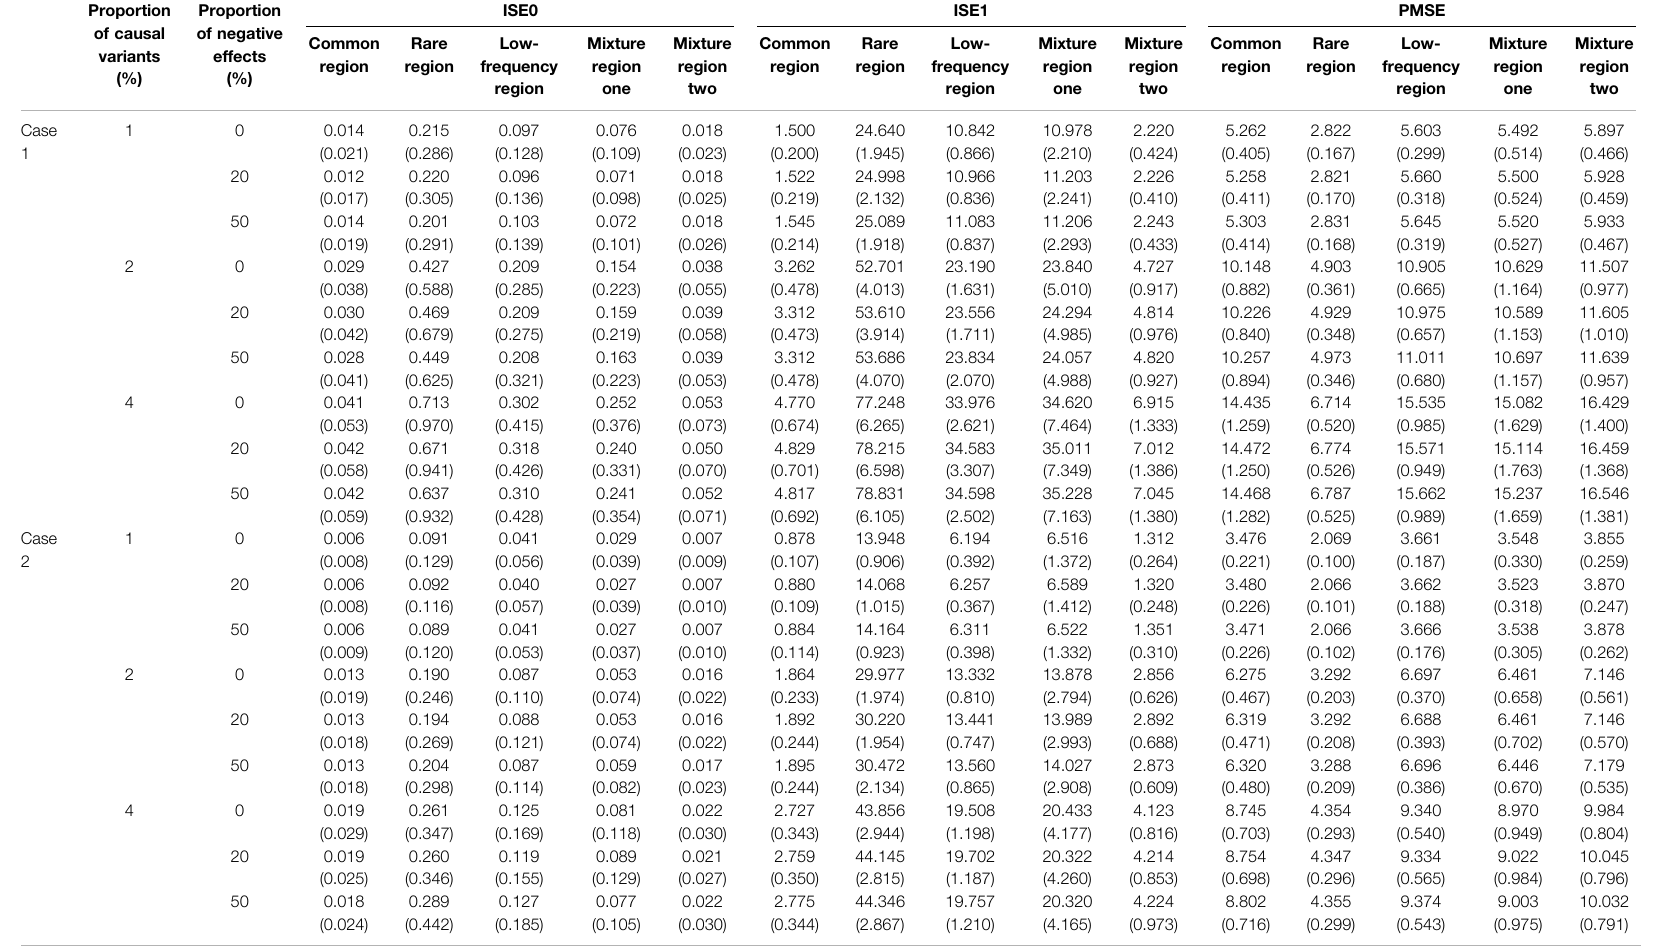
TABLE 6 | The means and standard errors (in the parenthesis) of three indicators based on LFDA for linkage disequilibrium simulation when sample size is 2000, c is 3 Proportion of